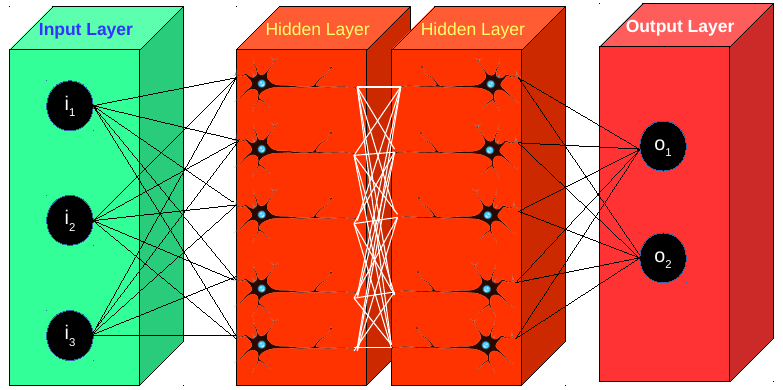
Figure 2. Example of the Multi-Layer Perceptron neural network with two hidden layers, three inputs and two outputs.